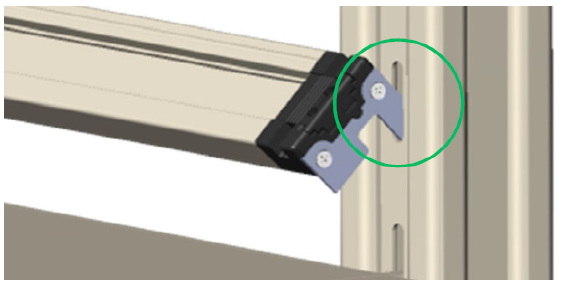
Figure 2. Particular of the generic installed hanging